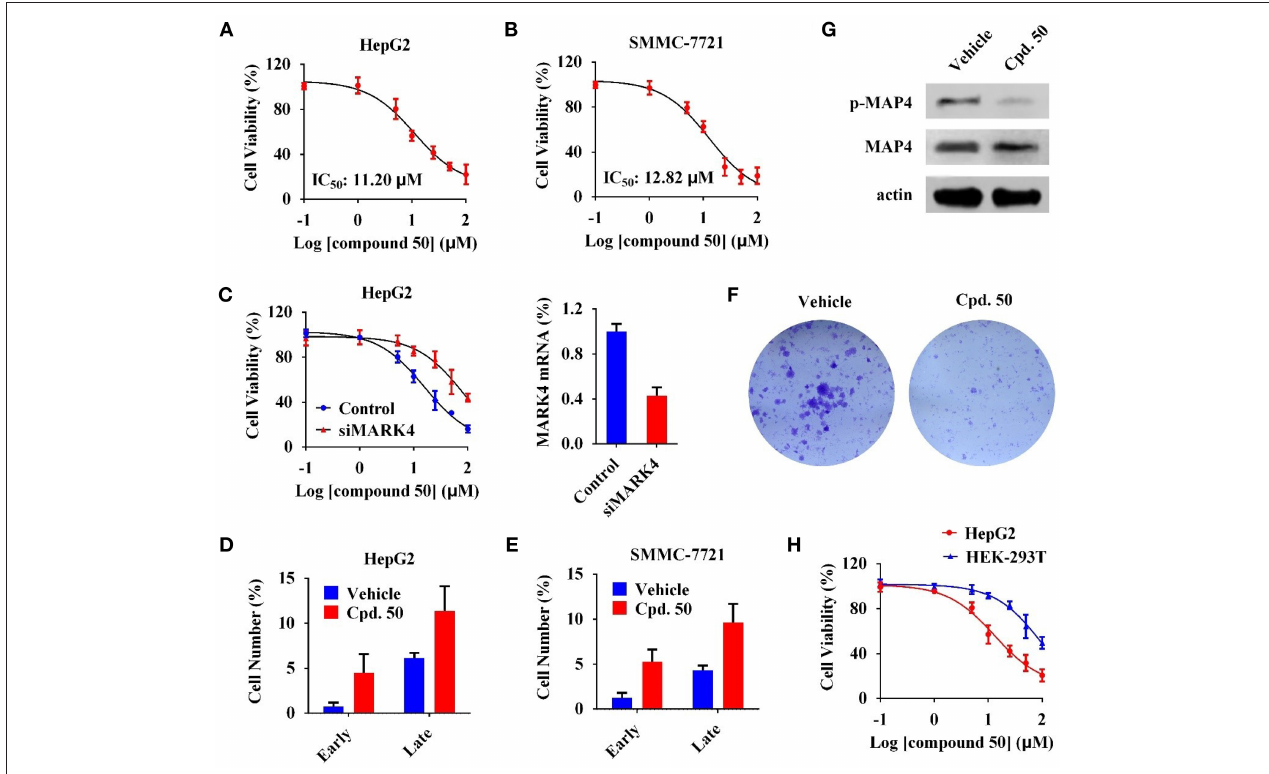
FIGURE 4 | Compound 50 suppressed cell viability and induced apoptosis of HCC cells in a MARK4-dependent manner. (A,B) Cell viability assay of compound 50 in (A) HepG2 and (B) SMMC-7721 cells. (C) (left) Cell viability assay of compound 50 in HepG2 cells transiently transfected MARK4-knockdown and control vectors. (right) MARK4-knowdown was confirmed by real-time quantitative PCR. (D,E) Cell apoptosis assay of compound 50 (15 µ M) in (D) HepG2 and (E) SMMC-7721 cells. (F) Colony formation assay of HepG2 cells with or without compound 50 treatment. (G) Immunoblotting against p-MAP4, MAP4, and actin antibodies of HepG2 cell lysates with or without the treatment of compound 50 (15 µ M). (H) Cell viability assay of compound 50 in HepG2 and HEK-293T